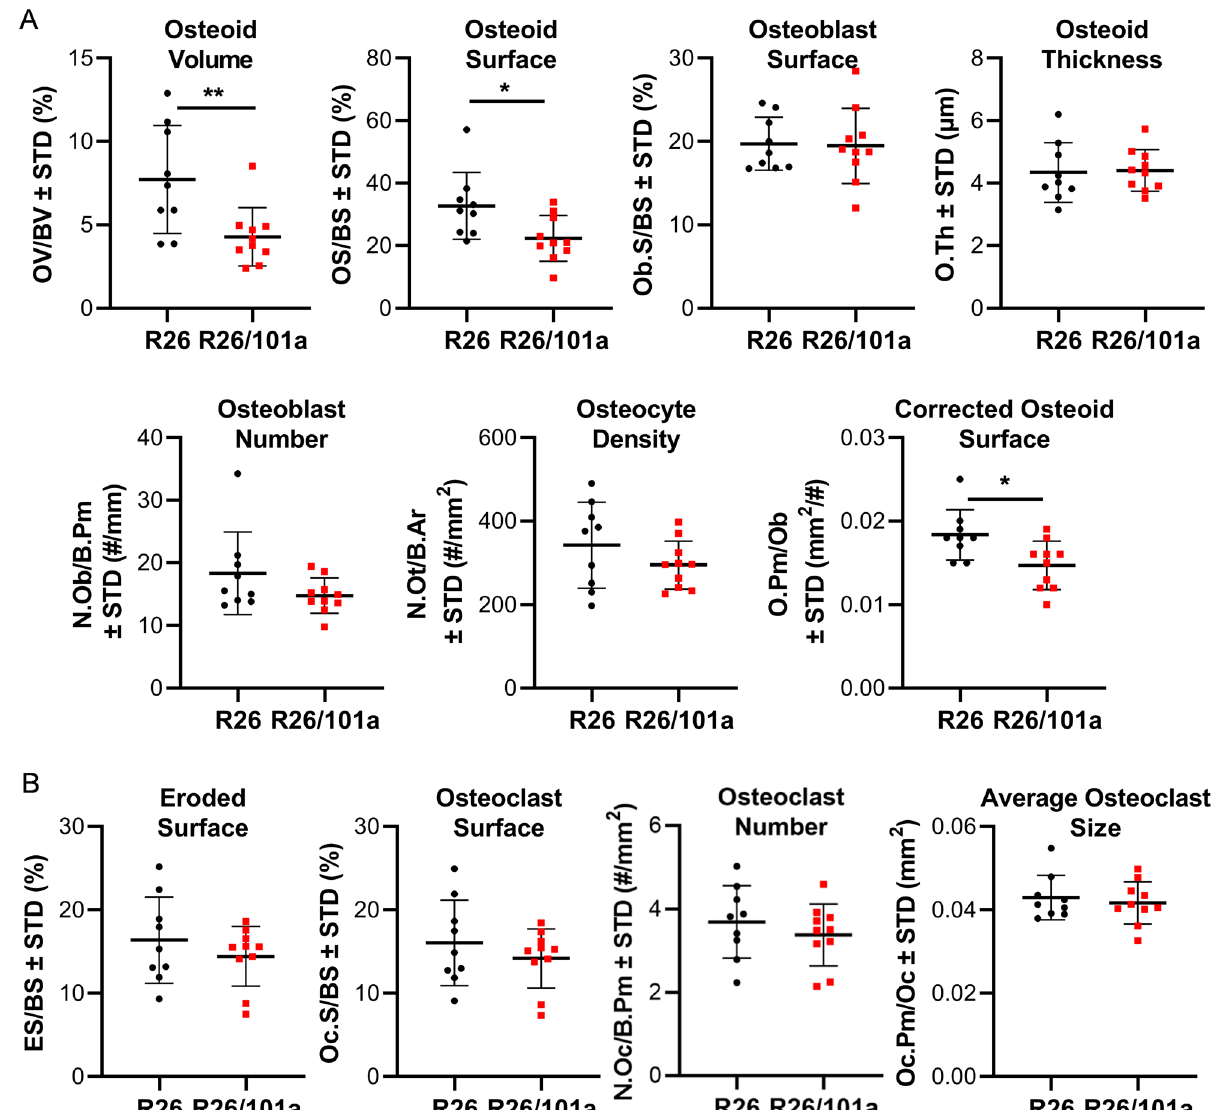
Figure 8. Histomorphometric alterations upon miR-101a over-expression in male mice. Femora (right) were collected from R26 control and miR-101a over-expressing (R26/101a) male mice treated with doxycycline from inception to sacrifice (8 weeks). The figure depicts histomorphometry measurements of von Kossa/McNeal- stained ( A ) and TRAPase/Toluidine blue-stained ( B ) sections derived from of sagittal femora slices (n = 9 to 10, mean ± STD). *p < 0.05 and **p <